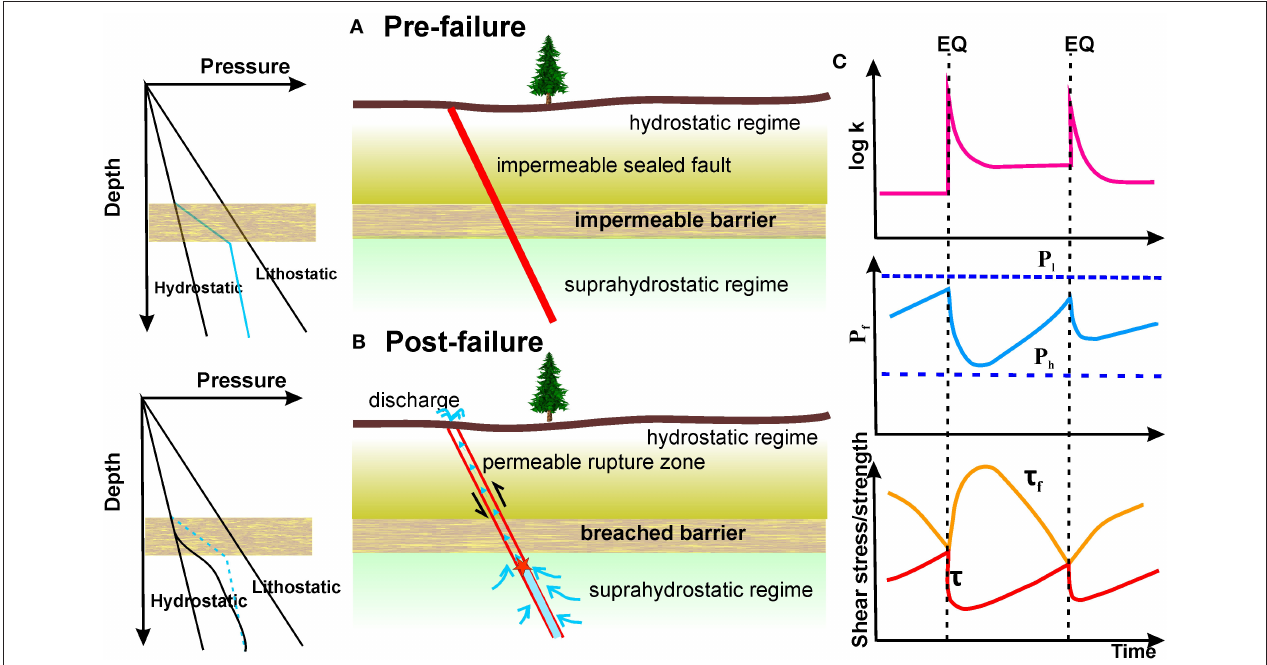
FIGURE 1 | Schematic representation of the fault valve behavior. (A) Pre-failure: on the left, the pore pressure gradient in the fault zone, above and below the impermeable barrier, i.e., the transition from the hydrostatic to the supra-hydrostatic flux regime (right); (B) post-failure: (right) an earthquake (red star) breaks the barrier, and the fluids rise upwards; on the left, the fluid pressure gradient is nearer to the hydrostatic curve; (C) scheme of fault valve action in relation to earthquake occurrence (EQ): when the impermeable barrier is broken, the local permeability k increases, allowing fluid discharge, decreasing fluid pressure P f , and increasing the frictional strength ( τ f ) (from Sibson, 2020, redrawn). P l , lithostatic pressure; P h , hydrostatic pressure; τ , tectonic shear stress (From Sibson, 1992, redrawn).